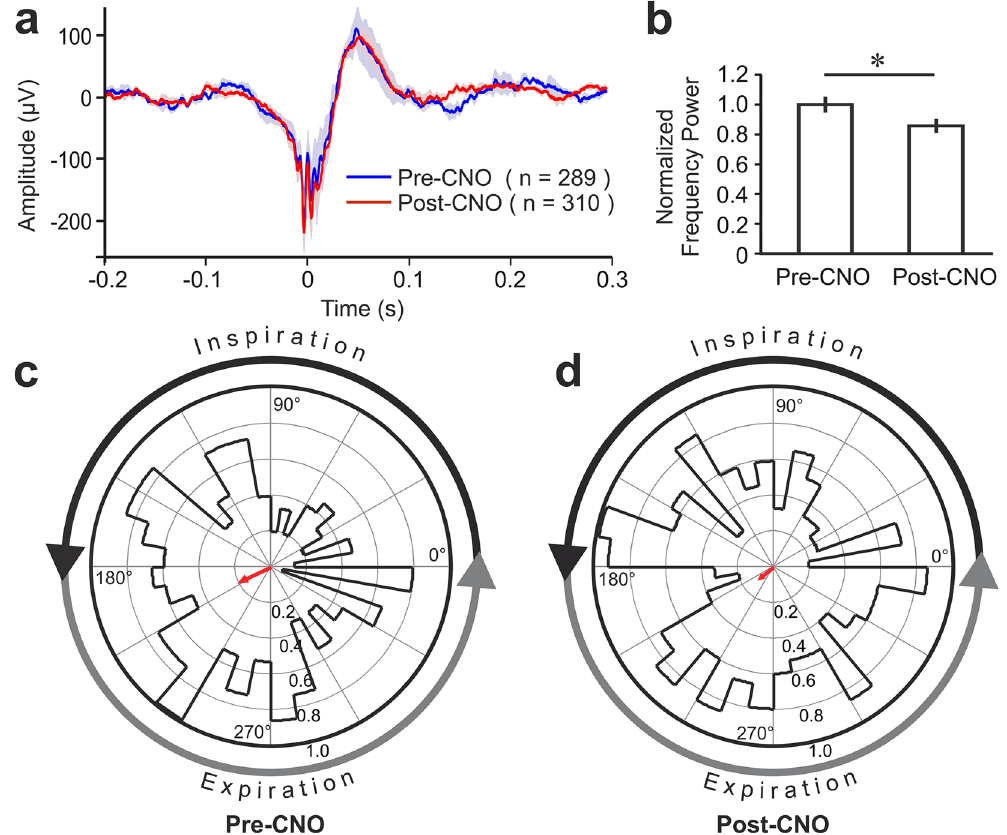
Figure 5. Changes in hippocampal sharp-wave ripple (SWR) activity before and after Clozapine N-oxide (CNO) Administration in mice with bilateral injections of DREADD vector in OB. ( a ) Average LFP waveform aligned on the SWR onset (t = 0). Solid blue and red lines represents mean LFP traces pre- and post-CNO treatment, respectively. Shading represents standard error. ( b ) Comparison of normalized spectral power within the 100–200 Hz frequency band pre- and post-CNO treatment. Two-Sample t-test: * p < 0.05. ( c ) Polar coordinates (°) for SWR activities during respiratory cycles, showing normalized vectors (thicker line areas) and mean vector length (red arrow; r) determined by circular statistics (Rayleigh test). 0° represents the end of expiration. The largest circle represents the maximum r (1.0). Pre-CNO: r = 0.18; z = 9.73; p < 0.001; Post-CNO: r = 0.09; z = 2.53; p =